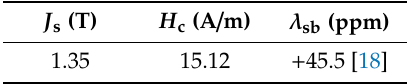
Table 3. Bulk magnetic parameters of the FeCoB ribbon: J s —saturation magnetic polarization;